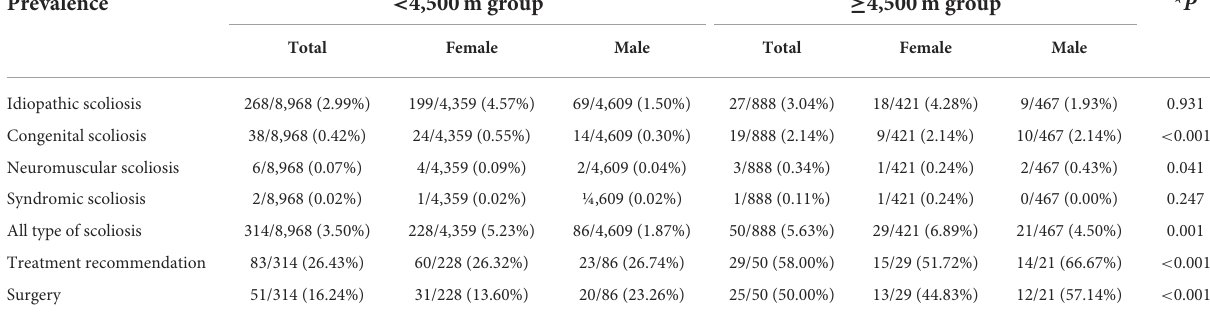
TABLE 1 Prevalence of scoliosis and type by altitudes of